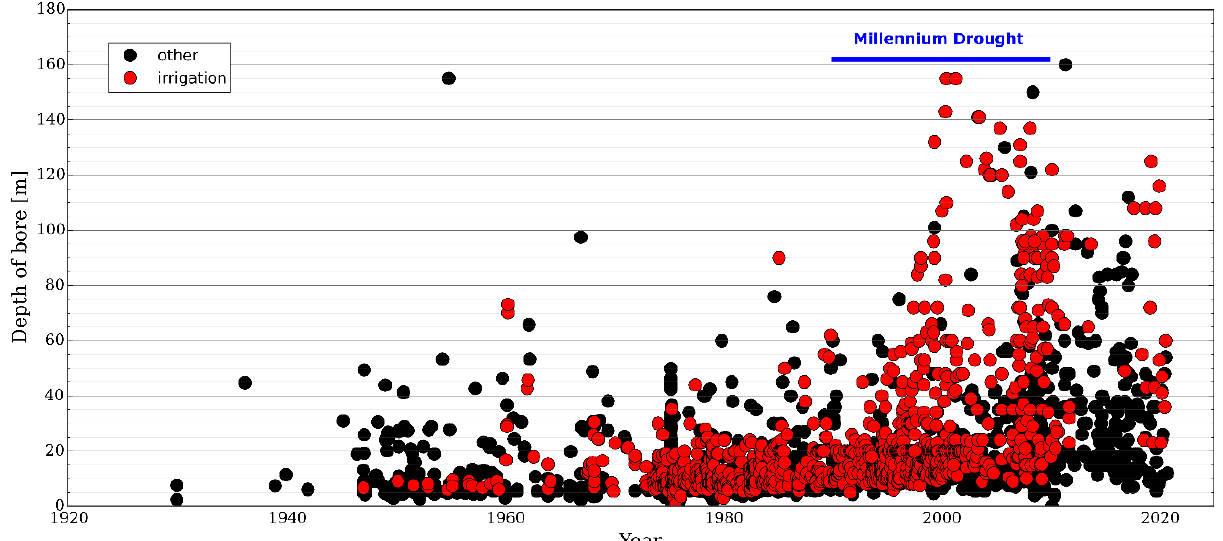
Figure 9. The drilled depth of bores in the study area has increased since the mid-1990s, coinciding with the onset of the “Millennium Drought.” Data obtained from the SA Government Groundwater Data: Obswell database [40].